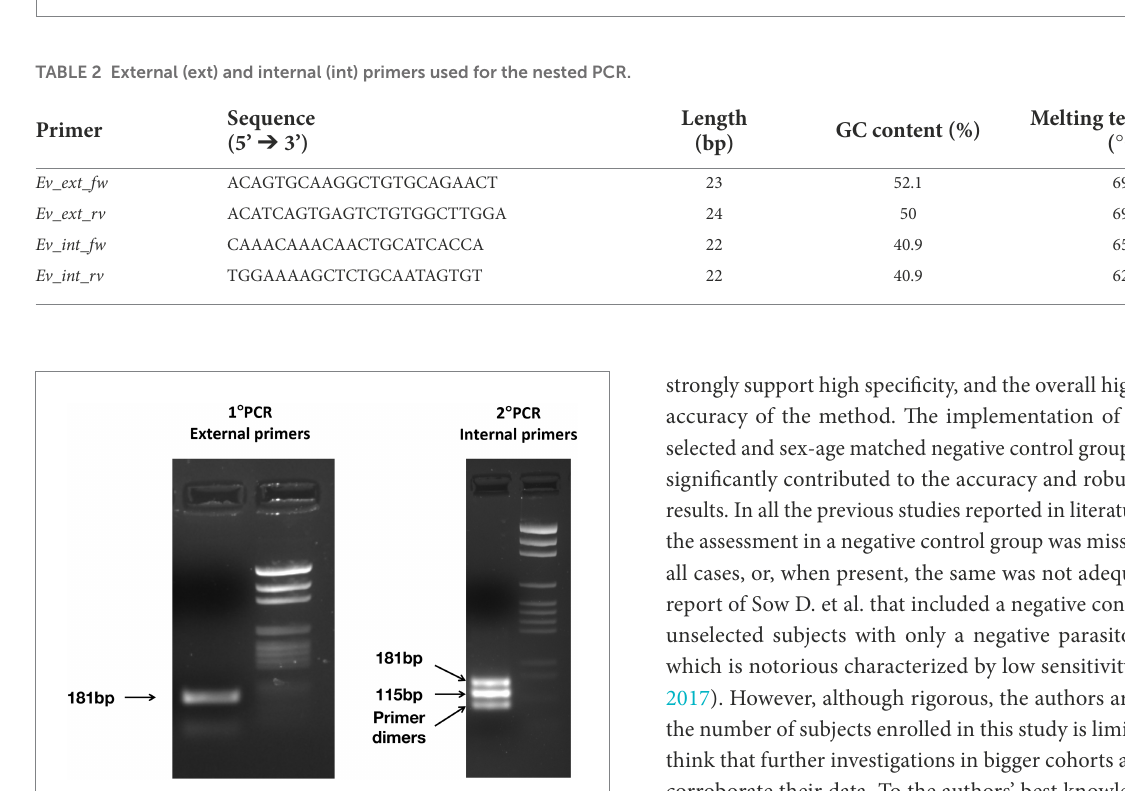
FIGURE 7 Electrophoresis of the PCR products was obtained after the first PCR (left panel) and the nested PCR (right panel) carried out on one positive control. In the left panel, one band of 181 bp is observed, on the right panel three bands: 182 and 116 bp from the nested PCR, while the lower band from primer